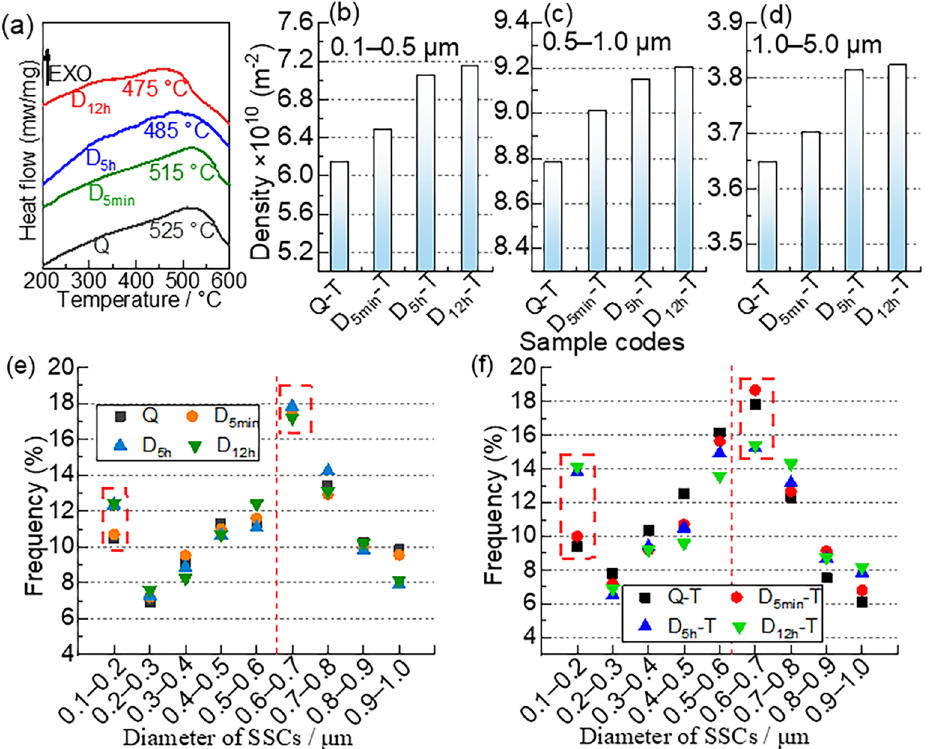
Figure 12. ( a ) DSC curves of Q and DCT samples, ( b – d ) the density of SCs, and the distribution of SCs in the ( e ) untempered and ( f ) tempered samples.